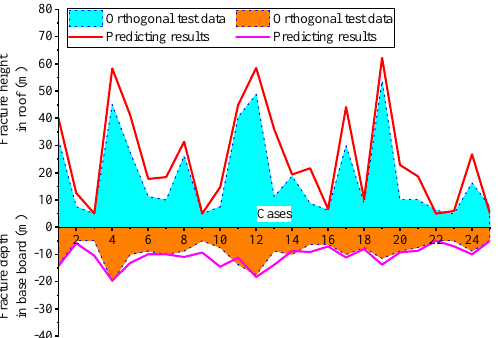
Figure 8. Comparison of the orthogonal test and prediction